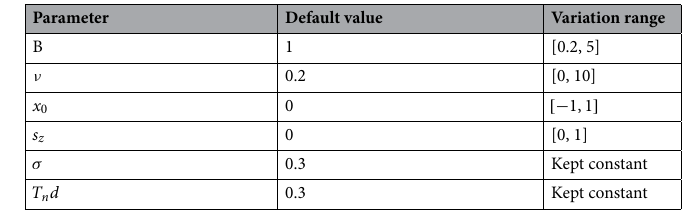
Table 8. List of DDM parameters used for simulations and subsequent correlation analysis. A uniform sampling of 100 values was performed over the variation range of each parameter. One parameter was varied at a time, using the default value for all the other